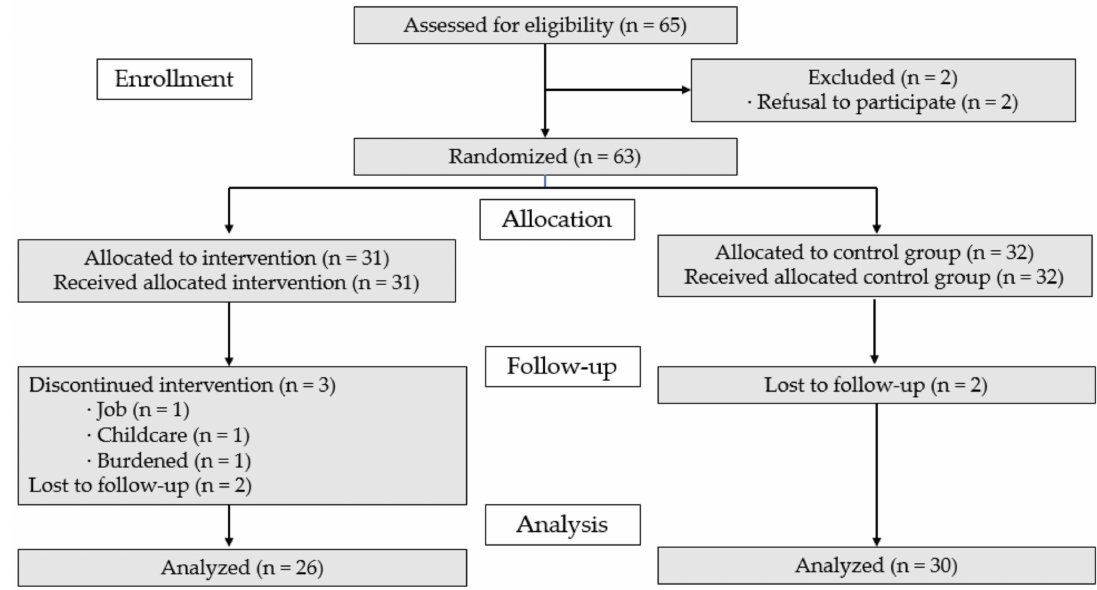
Figure 1. CONSORT